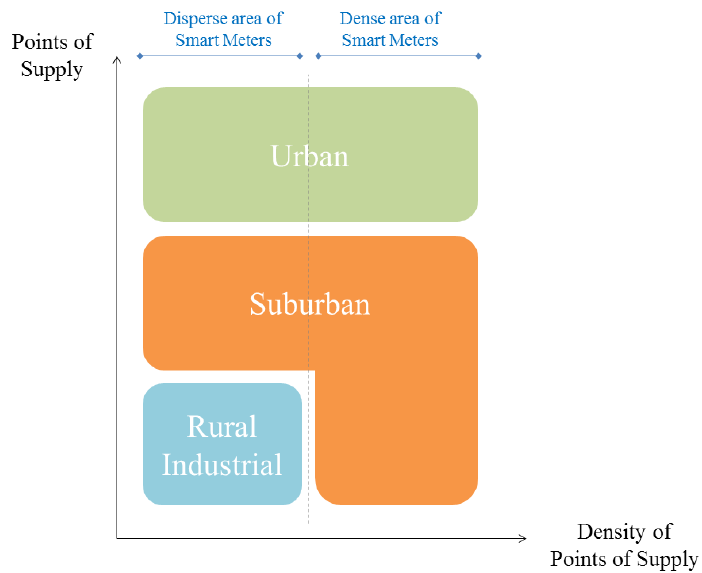
Figure 6. Classification of PLC performance